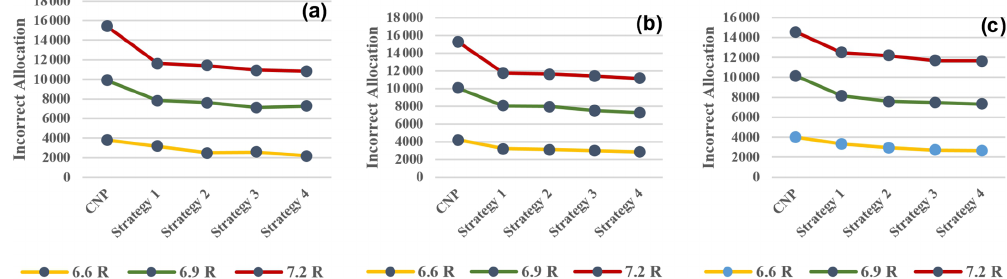
Figure 8. Numbers of incorrect allocations with (a) 1000, (b) 1500, and (c) 2000 rescue